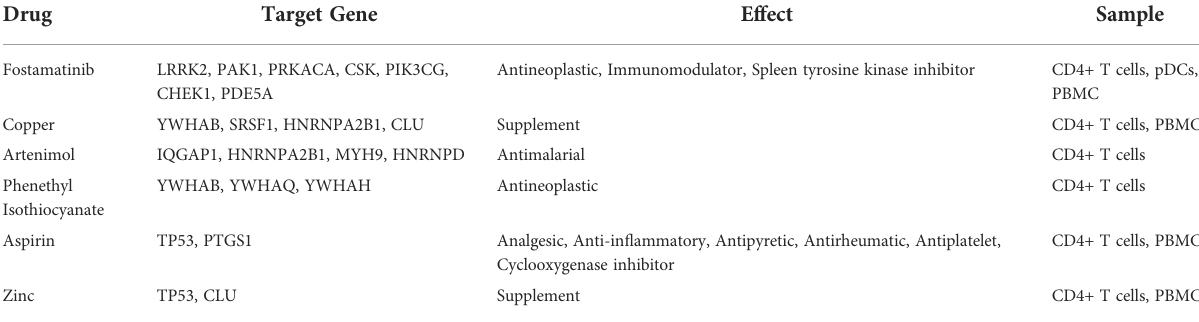
TABLE 3 The candidate drugs that target 2 or more than 2 hub target genes.